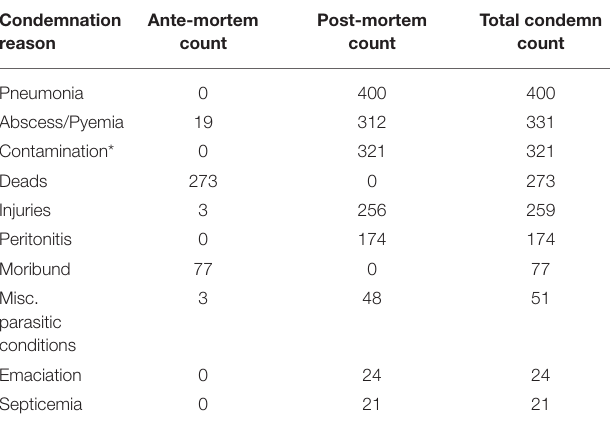
TABLE 3 | Total counts of 10 most frequent reasons for feral swine slaughter condemnation,